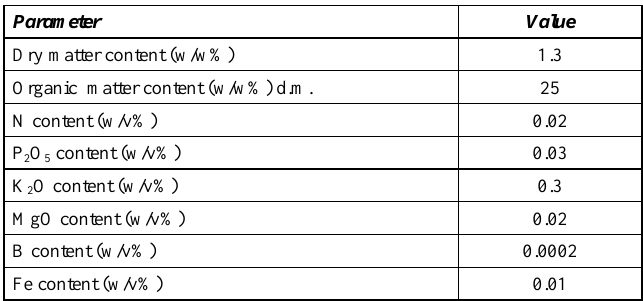
Table 2. Active ingredients of